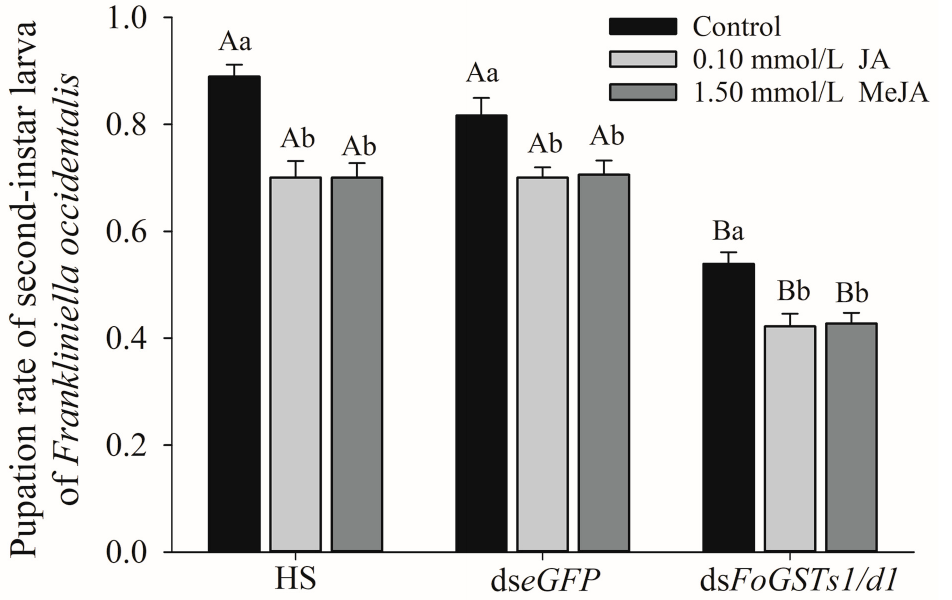
Figure 10. Co-silencing of FoGSTd1 and FoGSTs1 by RNA interference reduced the pupation rate of second-instar larvae of Frankliniella occidentalis feeding on jasmonic acid (JA)- and methyl jasmonate (MeJA)-induced kidney bean leaves. Values are the mean ± SE. Different lowercase letters indicate that the pupation rate of the second-instar larvae fed with the same solution was significantly different after feeding on the leaves of kidney bean with different induction treatments. Different uppercase letters indicate that the pupation rate of the second-instar larvae fed with different solutions was significantly different after feeding on the kidney bean leaves induced with the same treatment ( p < 0.05; one-way ANOVA, followed Tukey’s test). The second-instar larvae were pre-fed ds FoGSTs1/d1 solution and then transferred to leaves of control, JA-, and MeJA-induced kidney bean leaves for rearing. Pupation rates were significantly lower than those of larvae pre-fed HS and dse GFP solution. In the con- trol group, the second-instar larvae fed ds FoGSTs1/d1 had significantly lower pupation rates by 39.38% and 34.01% ( F 2, 15 = 49.674; p < 0.001) than those of larvae fed HS and ds eGFP solution, respectively. In the JA group, the pupation rate decreased significantly by 39.68% and 39.68% ( F 2, 15 = 41.126; p < 0.001), and in the MeJA group, the pupation rate decreased significantly by 38.89% and 42.78%, respectively ( F 2, 15 = 40.583; p < 0.001). 3. Discussion Because the injury-related plant hormones and signaling molecules JA and MeJA are widely distributed in plants, exogenous application can effectively trigger plant physio- logical and biochemical defense systems to increase resistance to herbivorous insects [12,42,43]. Insects have evolved mechanisms to adapt to various defense responses of host plants, especially toxic secondary metabolites produced by plants. Insects can use detoxi- fication enzyme systems such as cytochrome P450 enzymes, carboxylesterases, and GSTs in the gut and fat body to weaken the activity of anti-insect substances [2,19]. Among de- toxification enzymes, cytochrome P450 is the best-studied enzyme system for detoxifica- tion and metabolism of exogenous or endogenous toxic compounds in insects [44]. By contrast, the current study focused predominantly on GSTs. The expression levels of FoGSTd1 and FoGSTs1 mRNA were significantly upregulated after second-instar larvae of F. occidentalis fed on kidney bean leaves treated for 1, 3, and 5 d with different